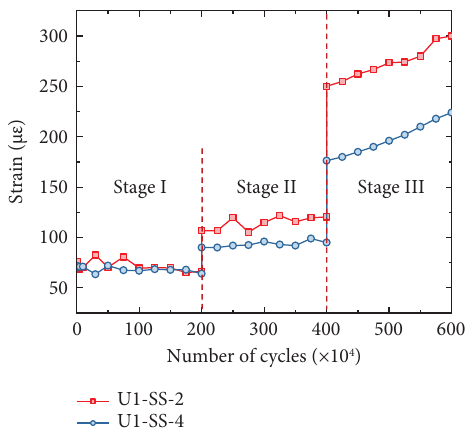
Figure 11: Variation laws of stress in steel rebars during fatigue test.